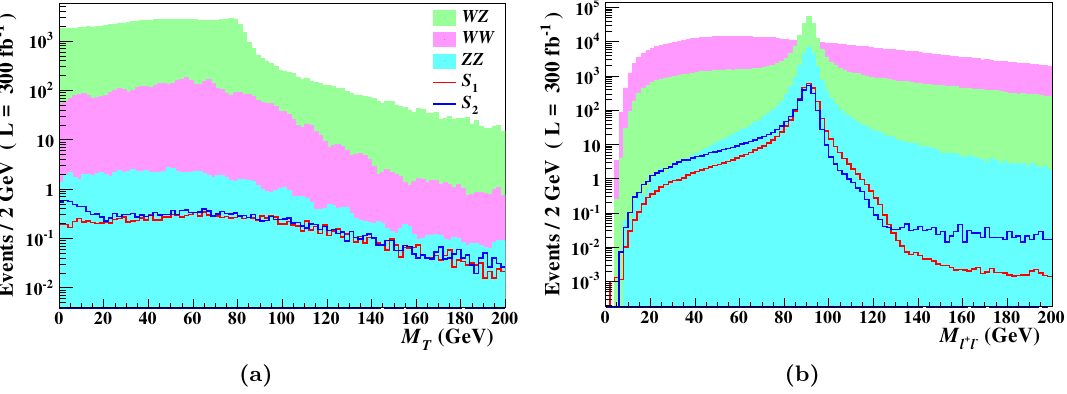
Figure 6. Cumulative number of signal and background events for BP1 versus =E p with s = 14 TeV for L = 300 fb (cid:0) 1 .